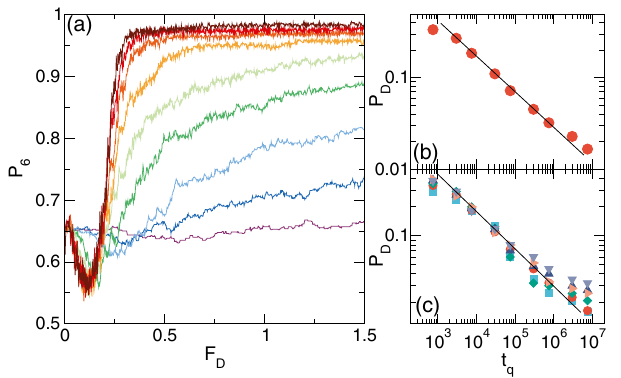
Fig. 3 Transition from the disordered to the ordered state for superconducting vortices as a function of quenching speed. a The fraction of sixfold coordinated vortices P 6 versus driving force F D for the system in Fig. 1 with vortex density n v = 1.0, pinning density n p = 0.5, pinning force F p = 0.4, and pinning radius r p = 0.3 at quench times of t q = 7.5×10 6 , 3×10 6 , 7.5×10 5 , 3×10 5 , 7.5×10 4 , 3×10 4 , 7.5×10 3 , 3×10 3 , and 750, from top to bottom. b The fi nal defect density P D = 1 − P 6 at F D = 1.5 in the same system versus t q . The solid line is a power-law fi t with exponent β = − 0.385. c P D versus t q for the same system at different values of F p = 0.2 (blue squares), 0.4 (red circles), 0.6 (green diamonds), 0.8 (blue up triangles), 1.0 (orange right triangles), and 1.2 (purple down triangles). The solid line is a power-law fi t with β = − 0.39. Error bars in ( b , c ) representing the uncertainty in the defect density, obtained from multiple realizations, are smaller than the data markers.